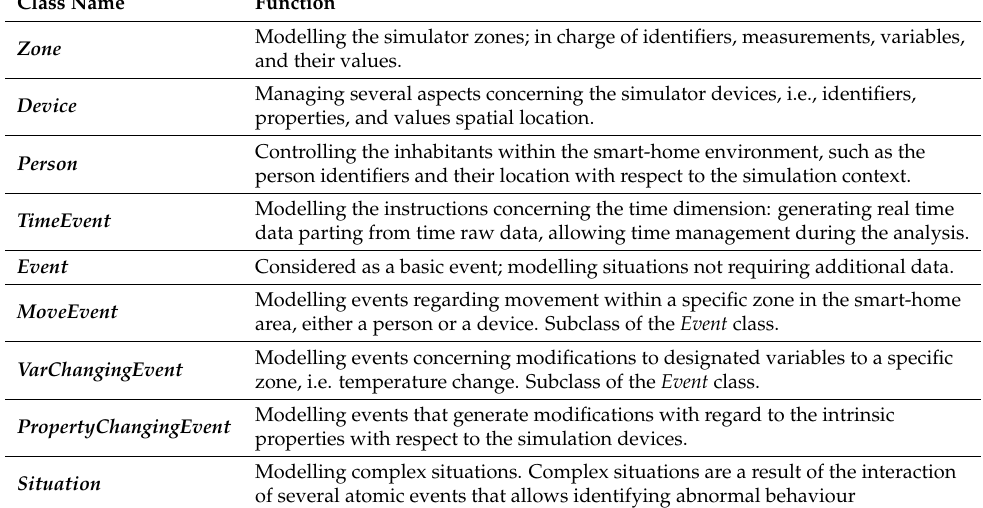
Table 15. Classes for data